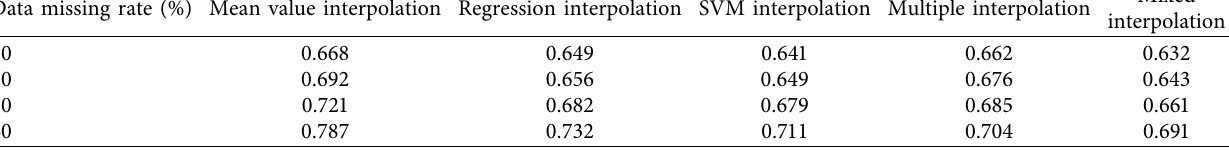
Table 4: RMSE values of the results of the five interpolation methods under different miss rates.